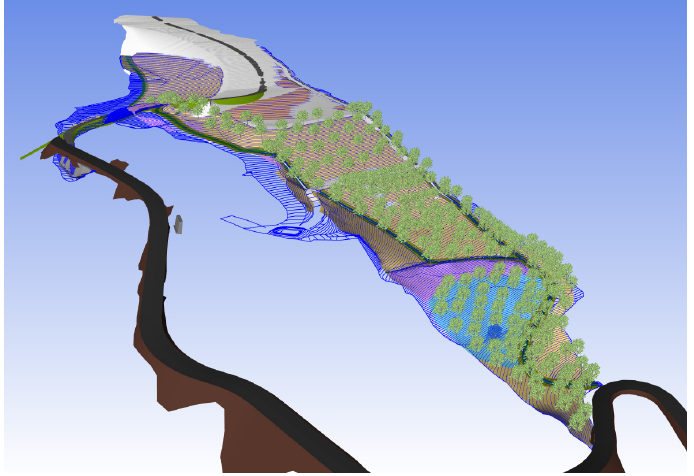
Figure 10. Landfill monitoring.